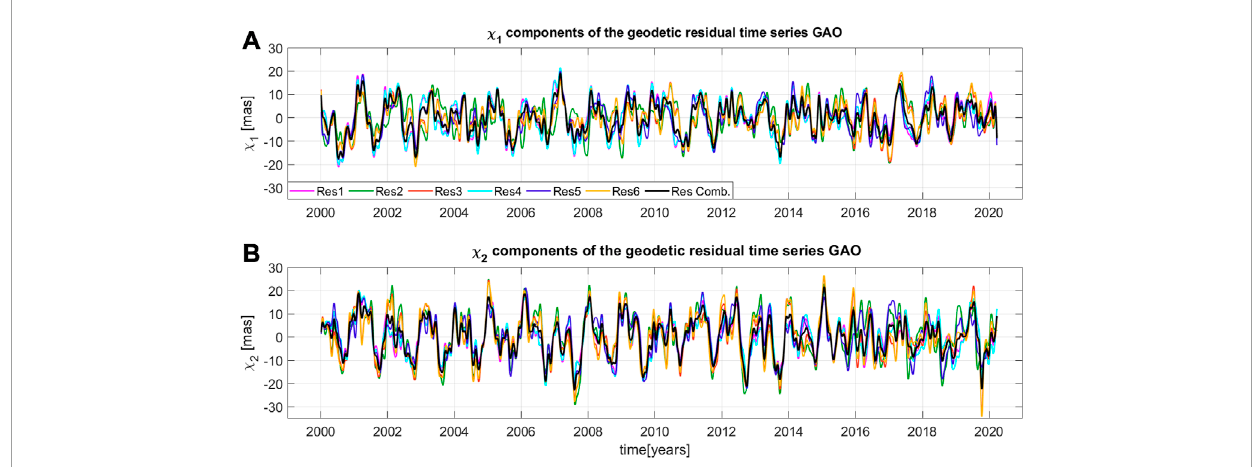
FIGURE 2 Time series of detrended χ 1 (A) and χ 2 (B) equatorial components of geodetic residuals (Res1, Res2, Res3, Res4, Res5, Res6, Res Comb.). Long-term oscillations, shown on Figure 1 were removed from original geodetic residuals GAO.